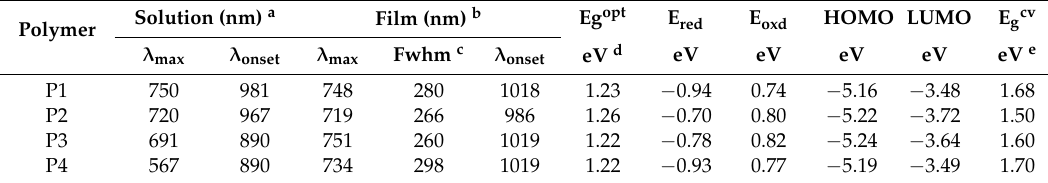
Table 1. The UV-vis spectra data and energy levels of four polymers.